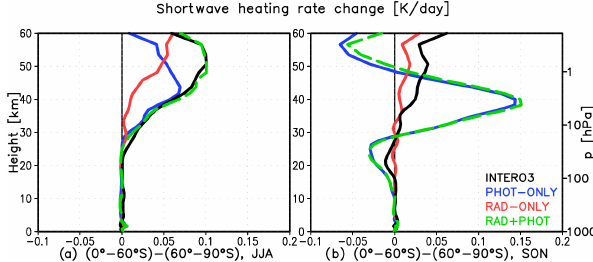
Figure 7. Seasonal mean JJA (a) and SON (b) change in the SWHR gradient (Kd − 1 ), as defined in Eq. (4), between SMAX and SMIN for INTERO3 (black), PHOT-ONLY (blue), RAD-ONLY (red), and for the sum of PHOT-ONLY and RAD-ONLY (green).